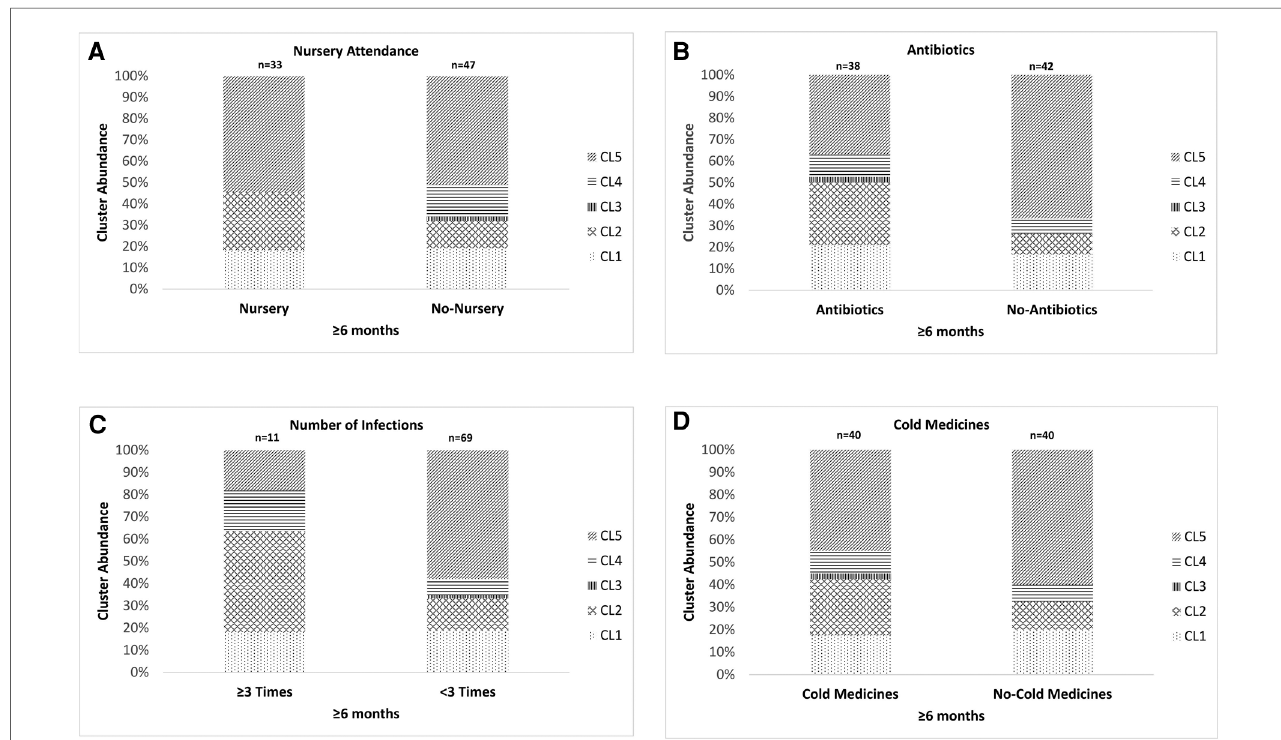
FIGURE 3 The association between the results of the clustering analysis using the URT secretions from the eligible children and the environmental factors. ( A ) Nursery attendance, ( B ) use of antibiotics after the latest sampling, ( C ) a history of ≥ 3 URTI episodes after the fi rst sampling and ( D ) use of cold medicines between the previous and present samplings. The URT secretions from children ≥ 6 months old were used for these analyses. The 5 clusters indicate Mixed (CL1), Haemophilus aegyptius/in fl uenzae- dominated (CL2), Staphylococcus aureus- dominated (CL3), Corynebacterium propinquum -dominated (CL4) and Moraxella catarrhalis/nonliquefaciens -dominated (CL5). Although the analyses were performed by using multiple samples collected from the same child, these samples were not always classi fi ed as the same cluster. URTI: upper respiratory tract infection, URT: upper respiratory tract, CL: